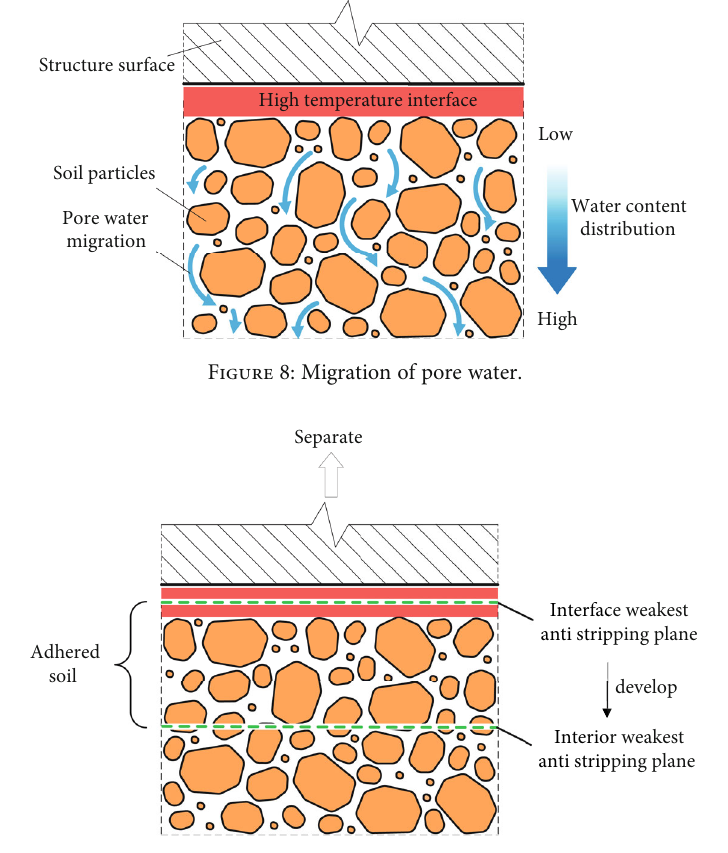
Figure 9: Development of failure